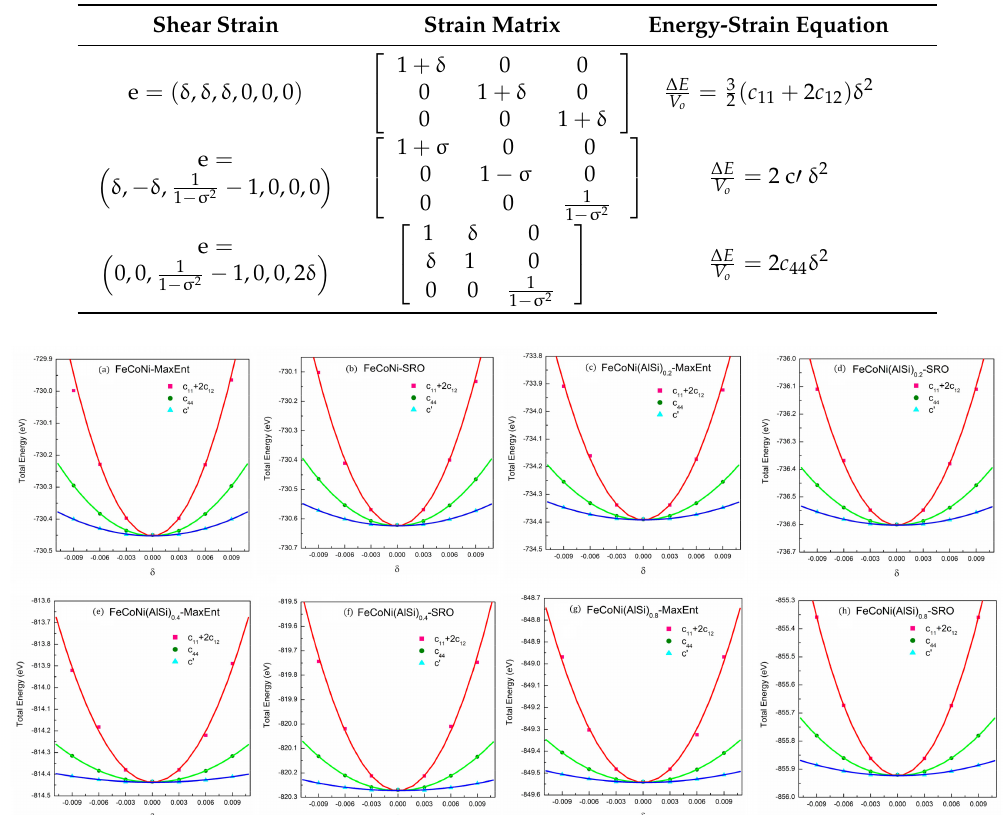
Table 6. The shear strain, strain matrix and the corresponding energy-strain equation to calculate c 11 , and c 44 for the cubic structure. Shear Strain Strain Matrix Energy-Strain Equation